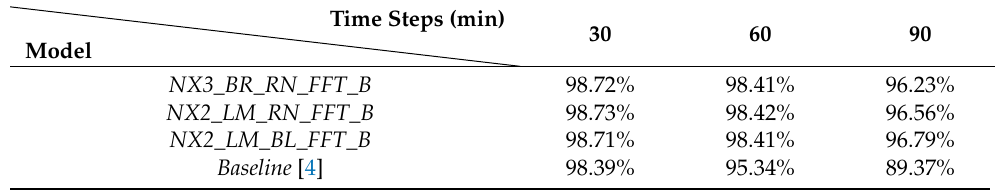
Table 3. A comparison between the 3 best models and the baseline in terms of correlation coefficient (R). Time Steps (min)